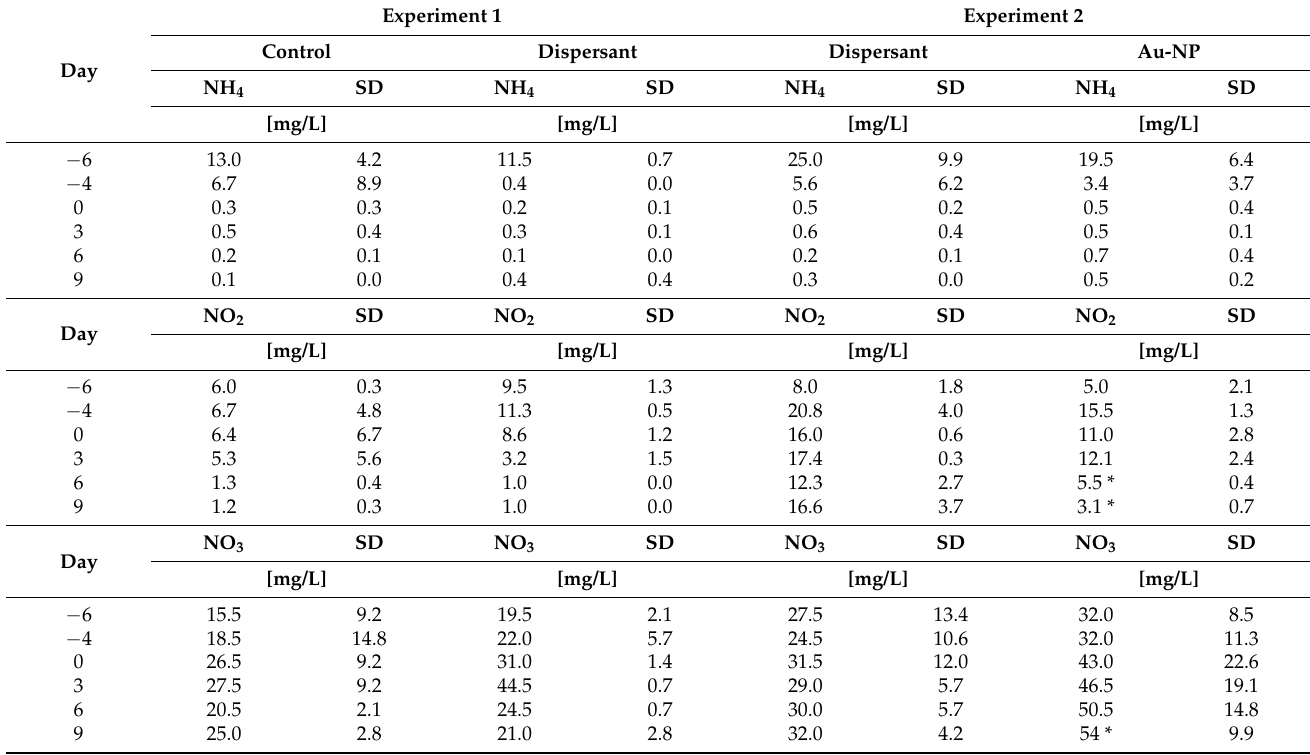
Table 3. Measured values of ammonium, nitrite, and nitrate in the effluent of the STPs in experiments 1 and 2. Student t -test. Alpha = 0.05; one sided smaller (nitrite) and one sided greater (nitrate). * p <